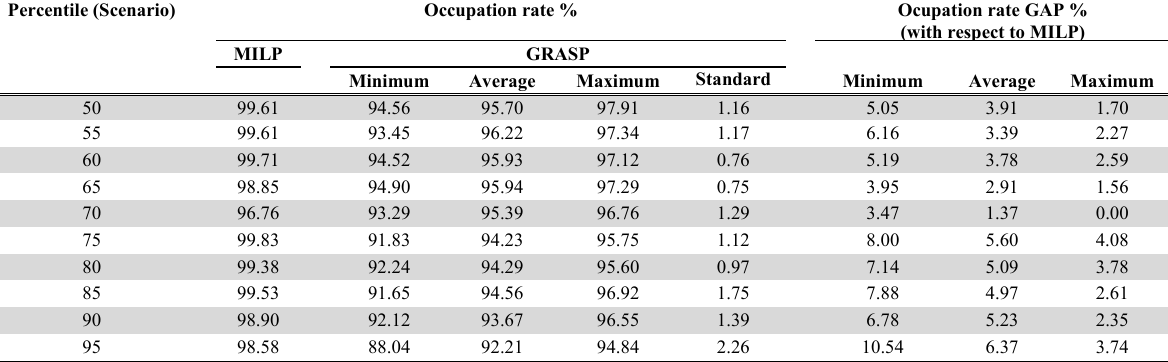
Occupation rate of MILP and GRASP, and GAP of GRASP for each scenario Percentile (Scenario) Occupation rate % Ocupation rate GAP %